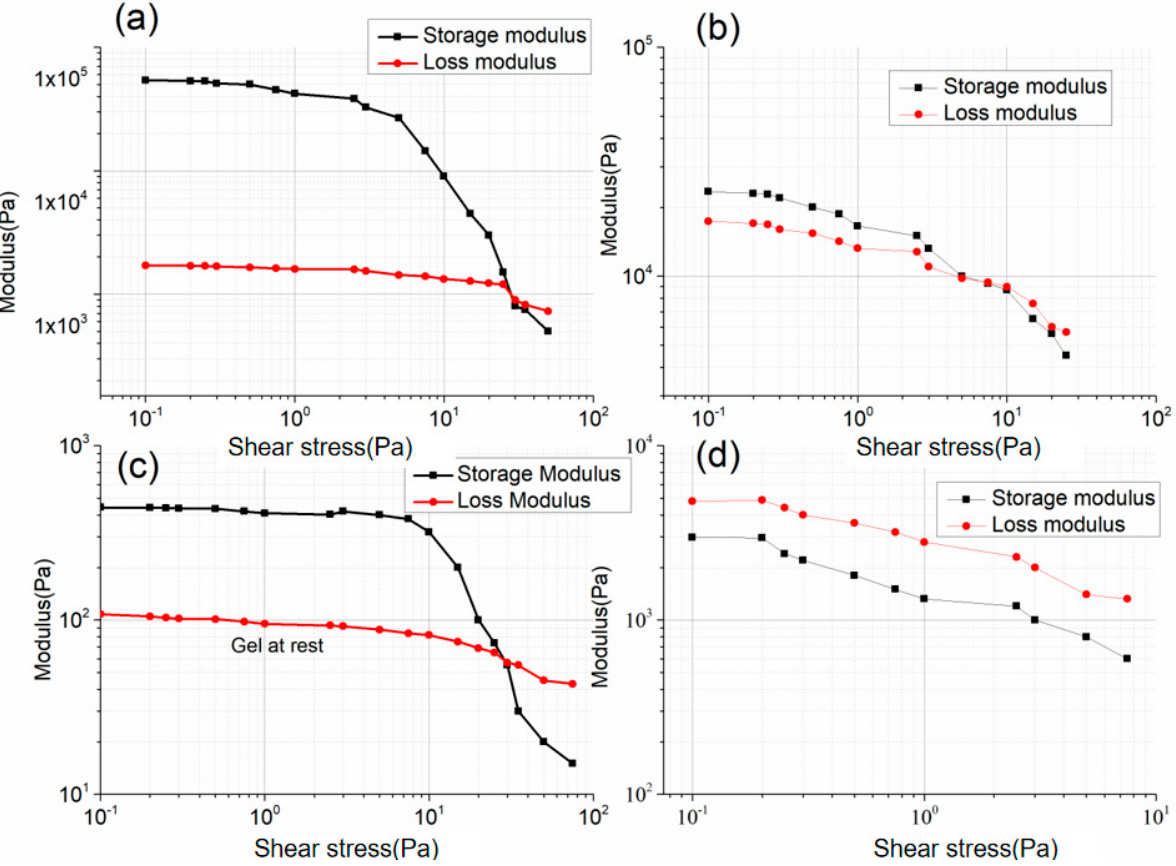
Figure 4. Plot of the storage modulus and loss modulus as a function of shear stress. ( a ) PVC-gel ink, ( b ) F-127 gel ink, ( c ) Ecoflex ink, ( d ) CNT/SMP composite ink.